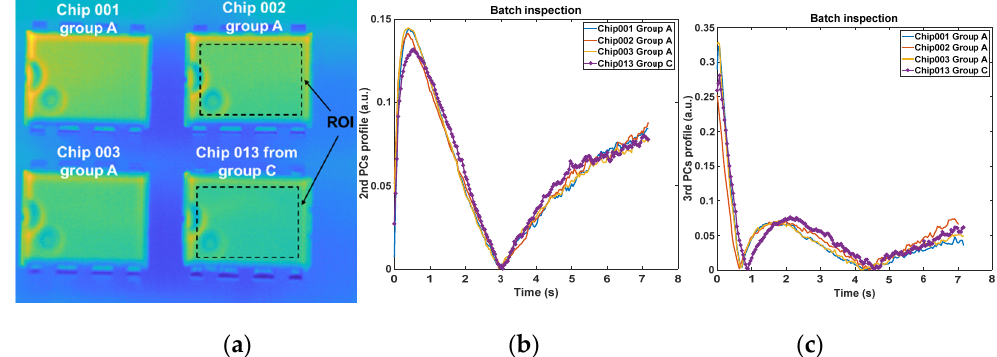
Figure 16. Results of the batch-chip inspection where 3 chips from Group A and 1 chip from Group C are inspected at the same time. ( a ) the first temperature frame (0.04 s) after the flash; ( b ) the 2nd principal component profiles; ( c ) the 3rd principal component profiles.